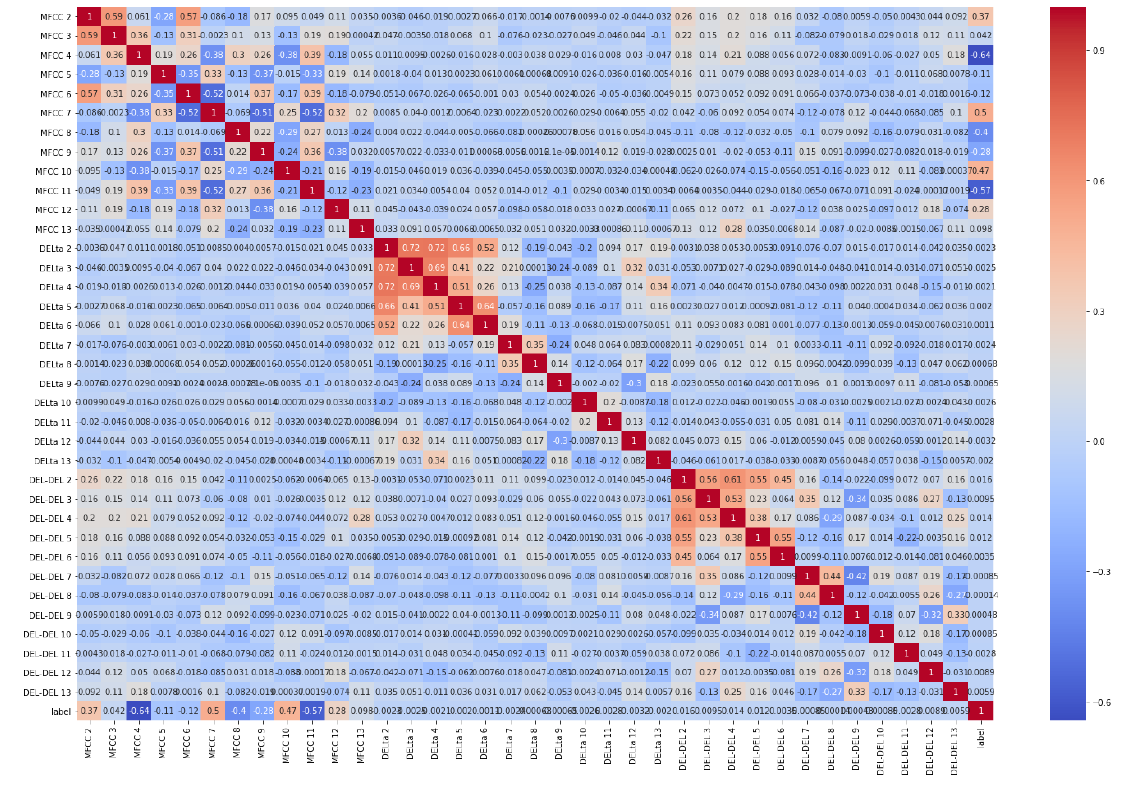
Figure A1. Correlation matrix of all the 36–dimensional feature vector.